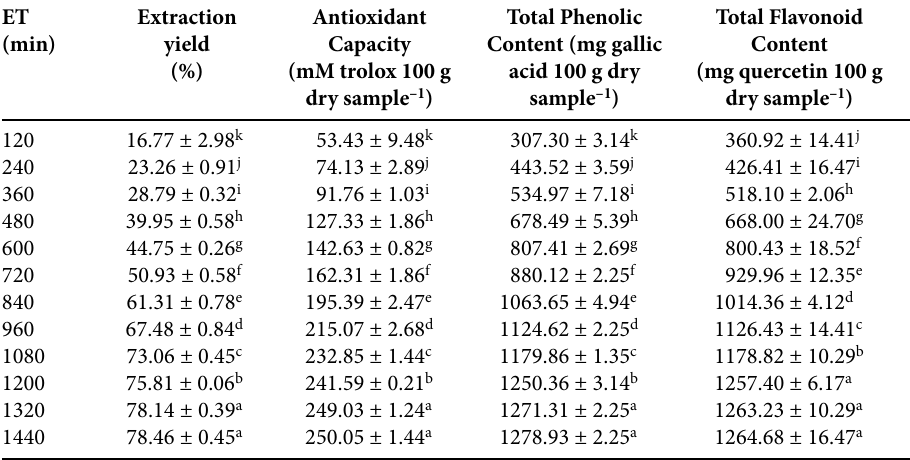
Table 1. Extraction yield, antioxidant capacity, total phenolic and total flavonoid contents for CE processes ET